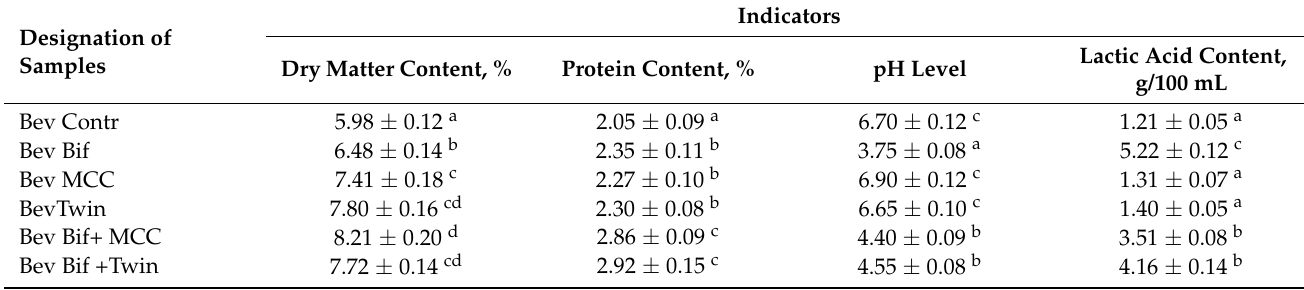
Table 2. Biochemical parameters of plant beverages stabilized with ME.